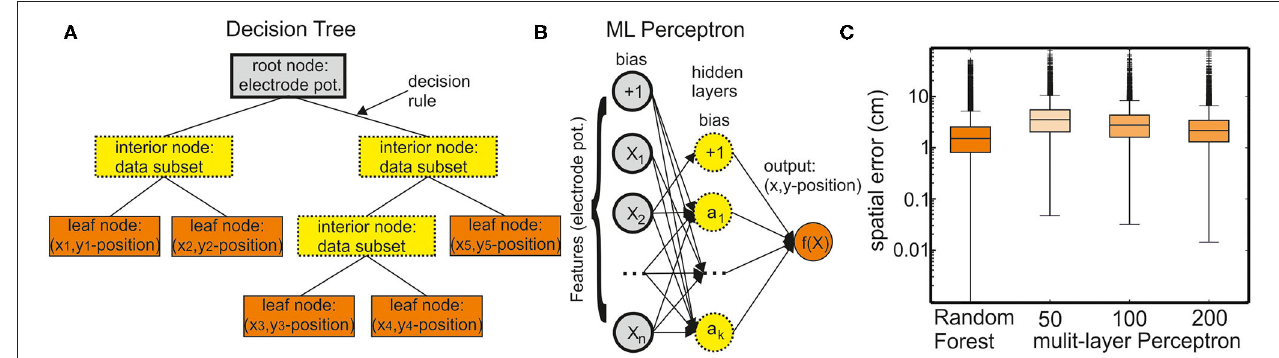
FIGURE 1 | Supervised learning methods for regression. (A) A decision tree comprises a root node containing all input data features, interior nodes containing subsets of the data, and leaf nodes containing the final target values. A decision tree can have different numbers of interior nodes and leaf nodes. The goal of a decision tree is to create a model that predicts the value of a target variable ( x and y position of the six fish skeleton coordinates) by learning the decision rules derived from the data (electrode potentials). (B) A multilayer perceptron (MLP) model can learn a nonlinear function approximation from a set of features and a target. The input layer comprises a set of neurons representing these input features (electrode potentials). Each neuron in the hidden layer transforms the values from the previous layer through a weighted linear summation followed by a nonlinear activation function. However, in case of a regressor model, the activation function is omitted (set to the identity function). The output layer receives the values from the last hidden layer and transforms them into output values ( x and y positions of the fish skeleton). (C) Comparison of the regression performance of the random forest regressor (RFR) and MLP models with different numbers of hidden layers. The spatial error is defined as the average distance between true and the model-estimated head position (anchor point, see also Figure 2 ).